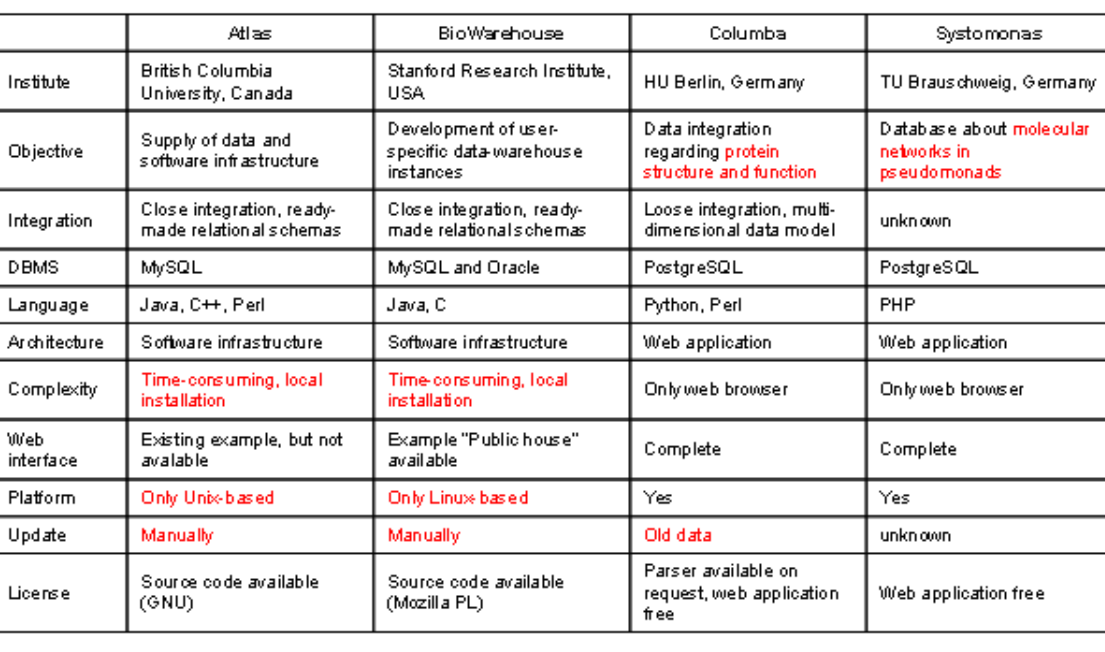
Table 1: Comparison of four exemplary bioinformatics data warehouses. Main restrictions of these approaches are highlighted in